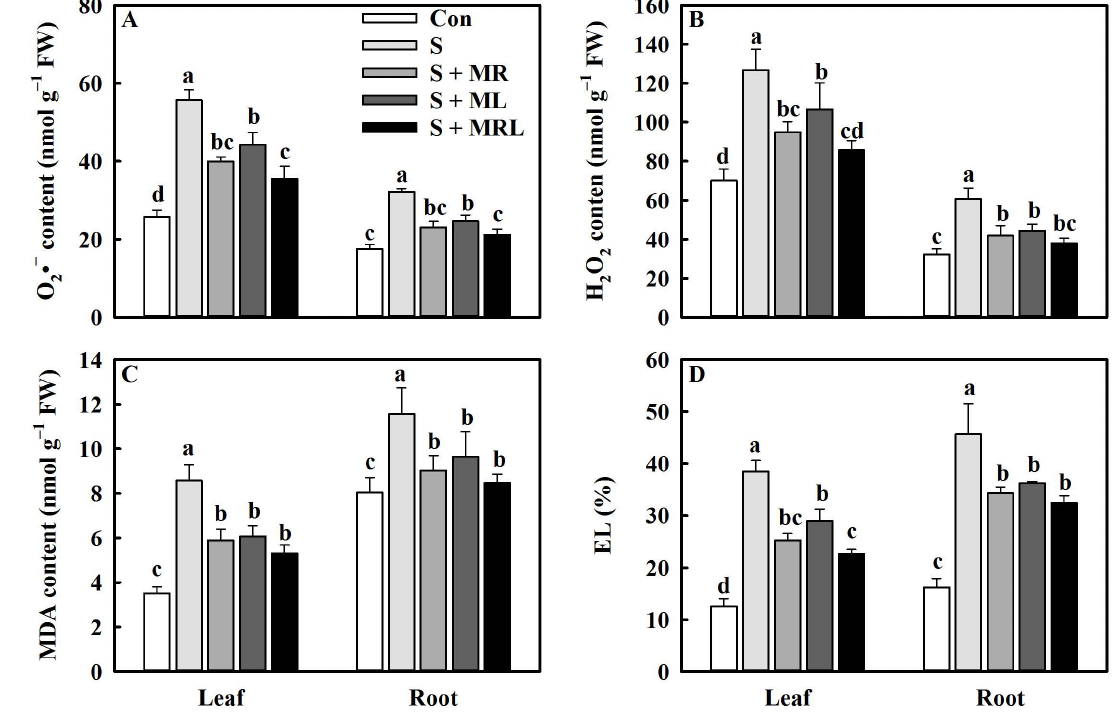
Figure 5. Effect of different methods of melatonin application on ROS generation and membrane stability of sugar beet seedlings under salt stress. ( A ) Superoxide anion (O 2 •− ) content, ( B ) hydrogen peroxide (H 2 O 2 ) content, ( C ) malondialde- hyde (MDA) content, and ( D ) electrolyte leakage (EL) in leaves and roots. Con, control treatment; S, salt stress treatment; S + MR, salt stress treatment + root application of melatonin; S + ML, salt stress treatment + foliar application of melatonin; S + MRL, salt stress treatment + combined root and foliar applications of melatonin. Data show the means ± standard errors ( n = 4). Different letters in the same column indicate significant differences between treatments according to Duncan’s multiple range test ( p <